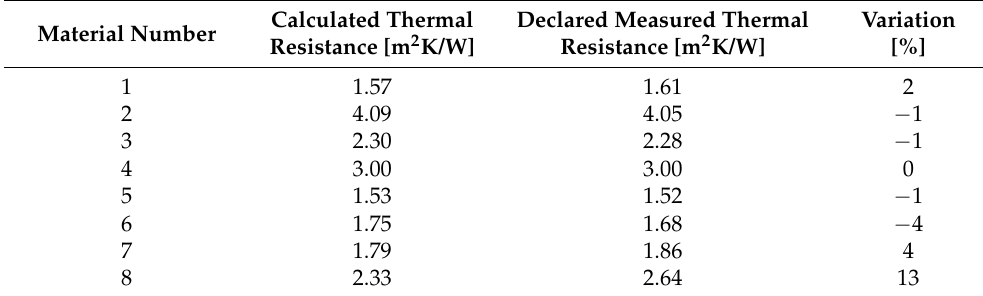
Table 6. Comparison between declared and calculated thermal resistance for eight heat-reflective materials available on the market. The trademarks are kept anonymous.